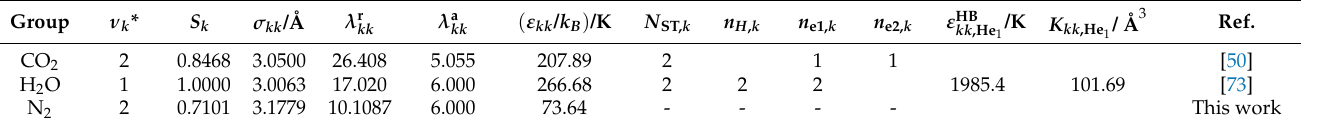
Table 11. Like group parameters used in SAFT- γ Mie modelling. ν k * is the number of segments constituting group S k , the shape factor and σ kk size of group k ; λ r the attractive exponent; ε kk is the Mie potential dispersion energy; N ST, k is the number of possible association site types in the group, n H , k , n e 1 ,k and n e 2, k are the number of association sites of type H, type e 1 and e 2 , respectively; and k B is the Boltzmann constant, k B = 1.380648813 · 10 − 23 J K − 1